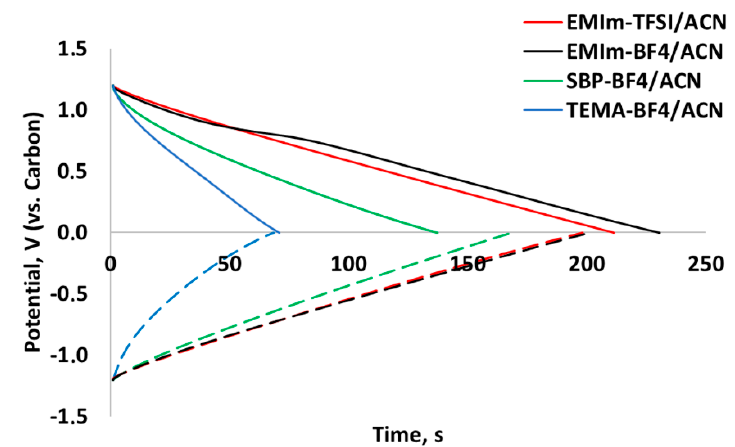
Figure 5. Discharge voltage profiles for positively and negatively charged electrodes at a current density of 0.5 mA cm 2 .